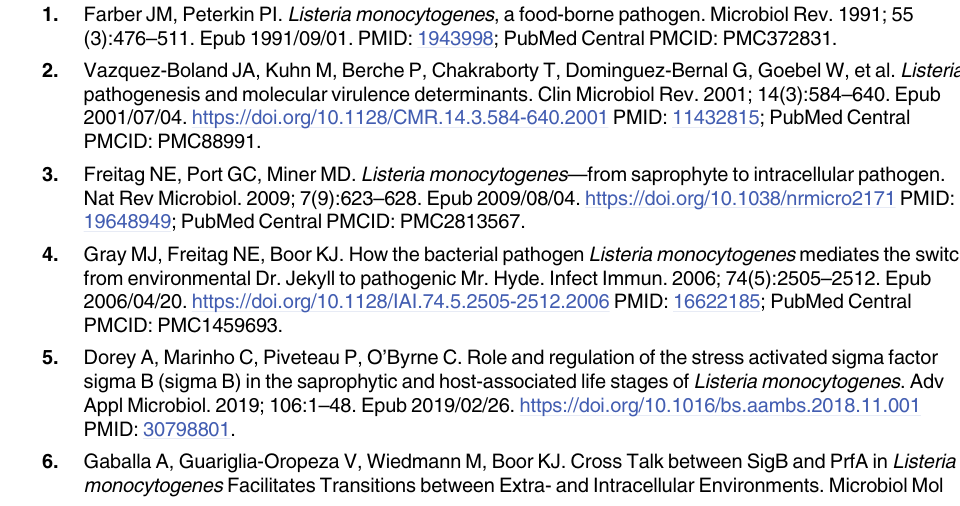
S2 Table. Oligonucleotides used in this